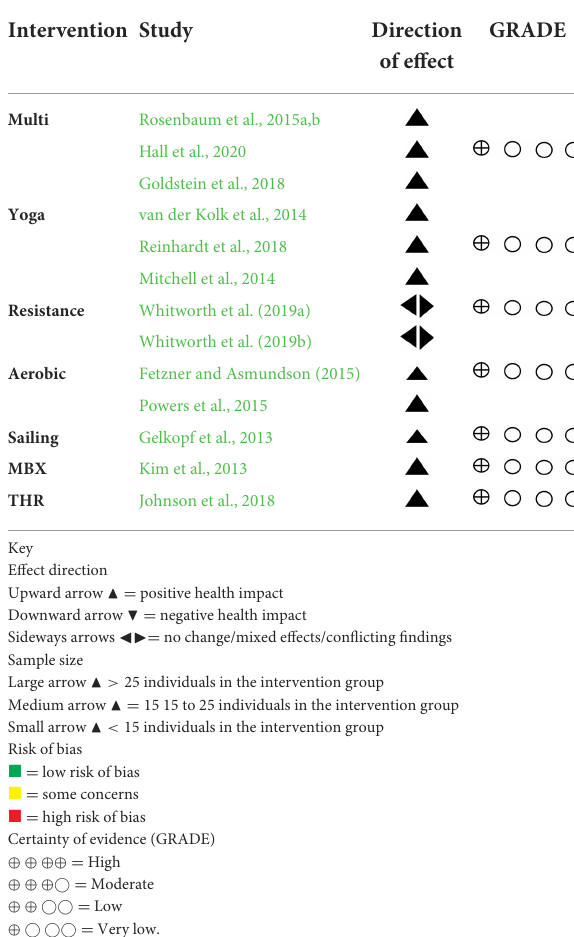
TABLE 4 Direction of effect Plot, RoB and certainty of